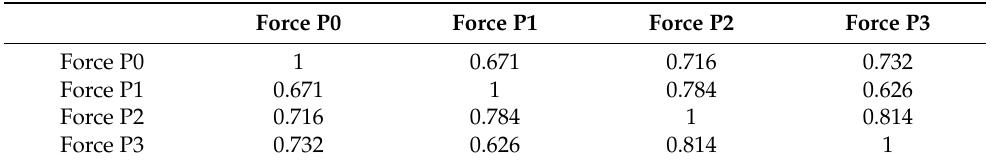
Table 7. Pearson’s correlations for ISEC volunteer strengths.